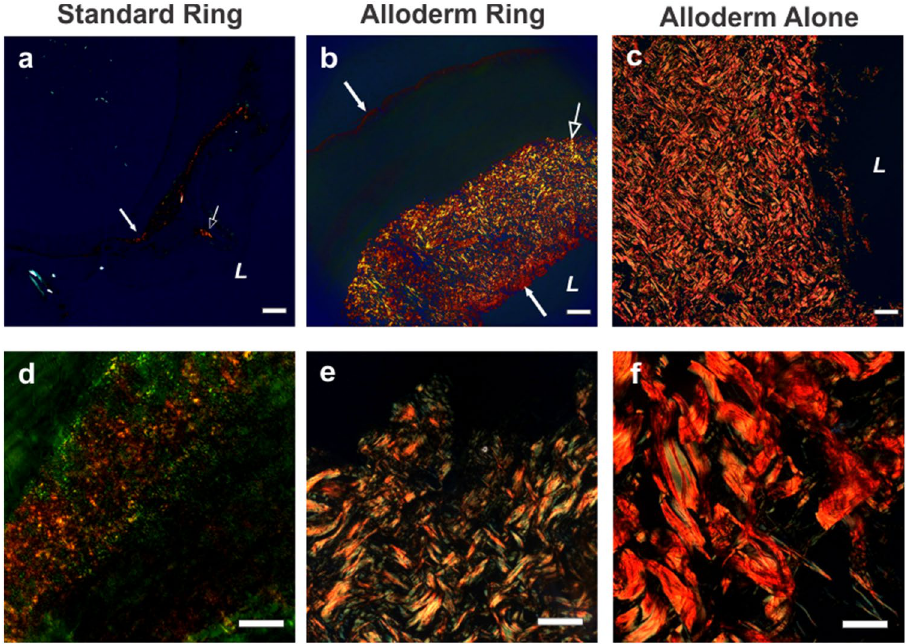
Figure 6. Increased collagen maturity of engineered vascular rings with incorporated Alloderm. Polarized light images of picrosirius red stained samples at ( a–c ) × 5 magnification and ( d–f ) × 40 magnification. Standard rings ( a,d ) exhibited mature red collagen fibers (white closed arrows) in the region of the cells and less mature yellow/ orange fibers (white open arrows) in the fibrin gel. ( b,e ) Alloderm-integrated rings exhibited a mix of mature red collagen fibers and less mature yellow/orange fibers, along with green fibers indicating least maturity which was likely newly deposited by the cells. More mature red collagen fibers were present in the ( c,f ) Alloderm group, with very few green fibers. ( a–c ) scale bars = 200 µm; ( d–f ) scale bars = 100 µm; L indicates the lumen side.